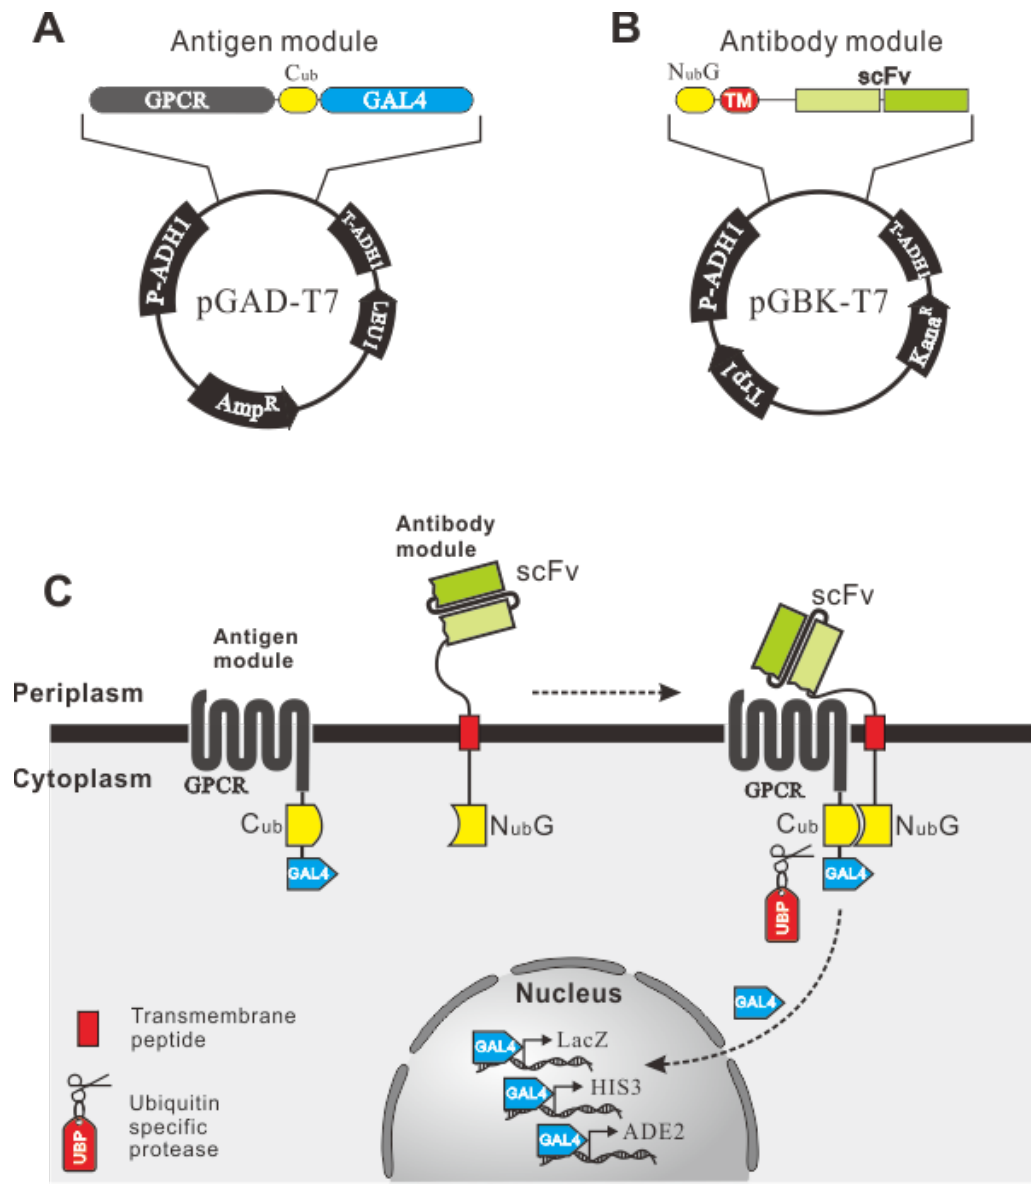
Figure 1. Design of the antibody and antigen plasmids and the principles of detecting the interaction. ( A ) The structure of the antigen plasmid. The antigen module is composed of G-protein-coupled receptor (GPCR), C ub , and GAL4 in tandem. The antigen genes were cloned into pGAD-T7. ( B ) The antibody plasmid structure. scFv is fused with a signal peptide (SP) at the N-terminus and a transmembrane peptide (TMP) at the C-terminus, followed by N ub G in tandem. The genes of the antibody module were cloned into pGBK-T7. ( C ) Principles of detecting the interaction. scFv is secreted outside the cytomembrane via SP and is linked with N ub G in the cytoplasm via the TMP. GPCR, as a transmembrane protein, is co-expressed on the plasma membrane linked to C ub and GAL4 in the cytoplasm. The interaction of scFv and GPCR units C ub and N ub G leads to reconstitution of split-ubiquitin, which is recognized and cleaved by UBP to release GAL4. The liberated GAL4 is transported into the nucleus via the SV40 nuclear localization signal at its N-terminus, and the transcription of reporter genes lacZ , HIS3 , and ADE2 results in blue clones on an SD/His − Ade − plate in the presence of X- α -Gal.